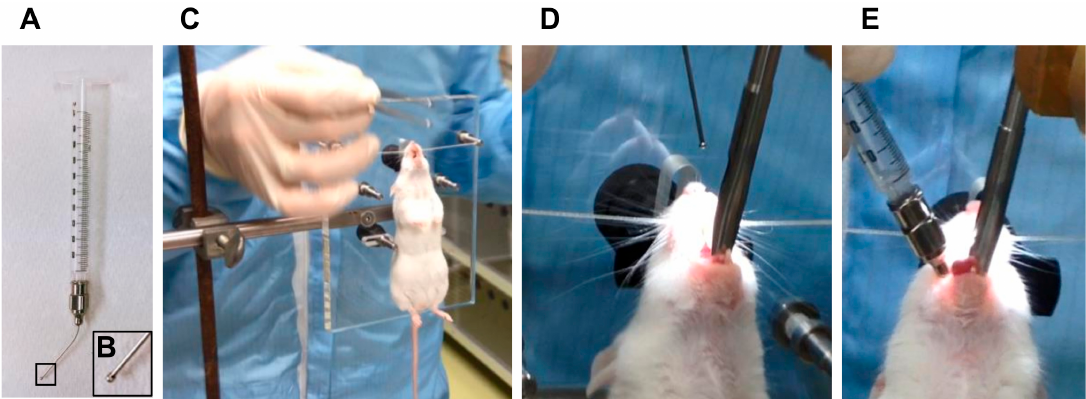
Figure 1. Steps for pulmonary administration to mice using the self-inhalation method. ( A ) Set-up of the administration syringe. ( B ) Enlarged view of the tip of the oral sonde. ( C ) Front teeth of the anesthetized mouse are retained at approximately 90° in the retaining position. ( D ) Visualization of the trachea using a small animal laryngoscope. ( E ) A feeding needle attached to a syringe is inserted into the trachea of the mouse, and the test agent is self-inhaled by the mouse without using the syringe plunger.